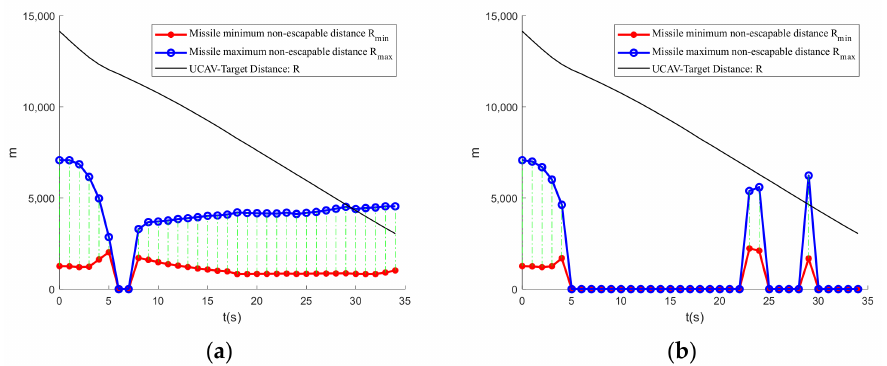
Figure 11. UCAV-enemy relative distance and missile inescapable distance curve. ( a ) UCAV; ( b ) enemy.